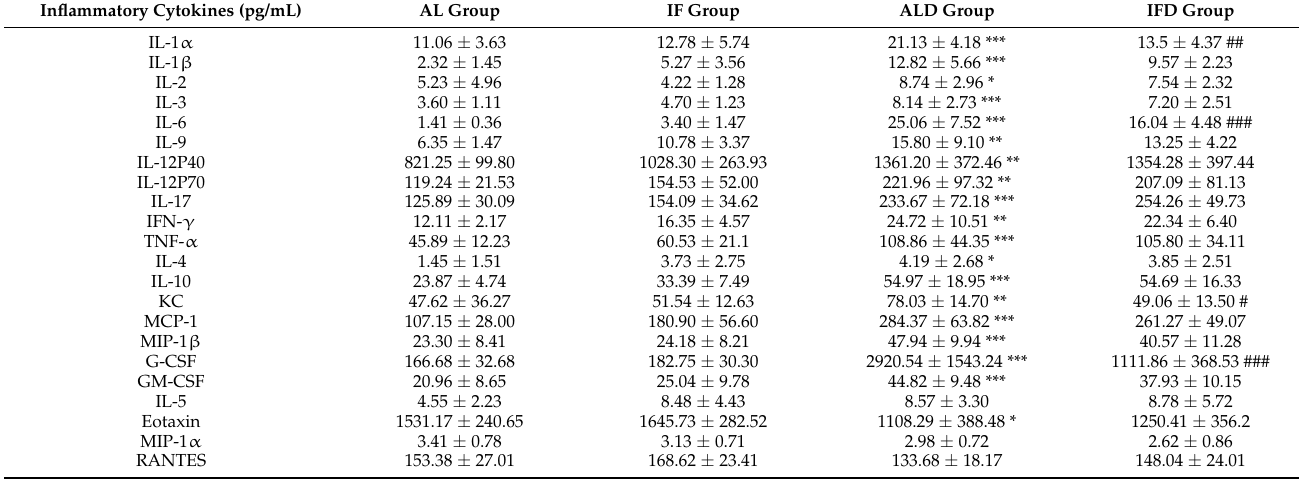
1531.17 ± 240.65 Data are shown as the mean ± SEM. AL: ad libitum-fed group; IF: intermittent fasting group; ALD: ad libitum-fed group with DSS; IFD: intermittent fasting group with DSS. ALD group compared with AL group, * p < 0.05, ** p < 0.01, *** p < 0.001; ALD group compared with IFD group, # p < 0.05, ## p < 0.01, ### p <